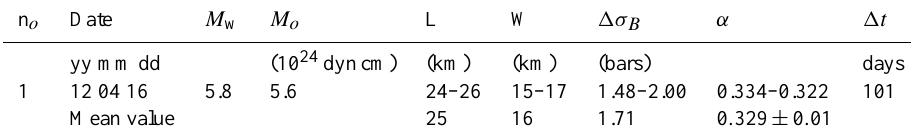
Table 1. The USGS reported date and magnitude of the earthquake along with its seismic moment M o , range of values in the dimensions of its aftershock area L and W, corresponding calculated values for 1σ B , the critical exponent α and the lead time 1t . Mean values are also given for the relevant parameters.